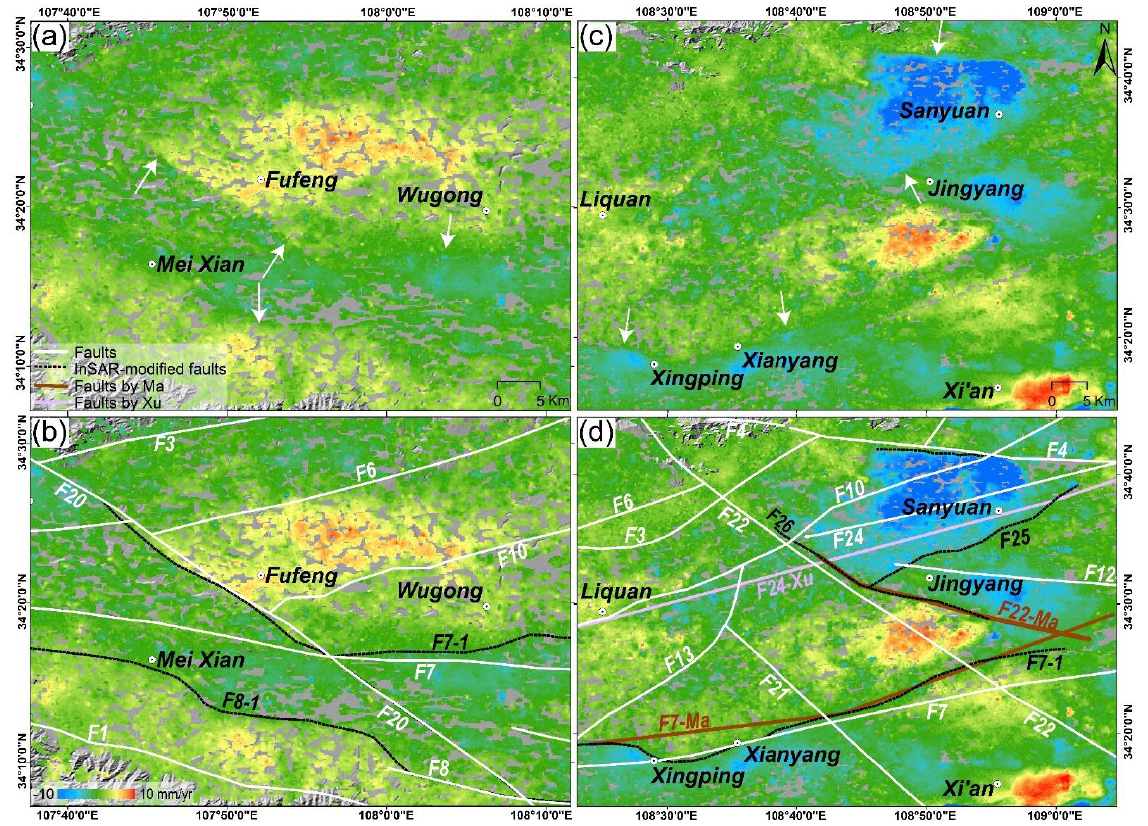
Figure 8. Enlarged vertical deformation maps over the Fufeng ( a , b ) and Sanyuan ( c , d ) regions, where the mapped faults (white lines) [18], InSAR-modified faults (black lines), and faults in Ma et al., 2018 (brown lines) [53] and Xu et al., 2017 (pink line) [54], and the main cities are superimposed. In addition to the modification of active fault positions in regard to [18], we also drew two new fault lines over the Jingyang area, i.e., F25 and F26, based upon our InSAR dis- continuities. The mapped F25 tends to trend parallel to F10, F24, and F24-Xu in an ENE direction, and bound the Sanyuan subsidence cone in the south [18,37]. It looks as if F25 is involved in a listric faulting system together with F24, and the existence of F24, F24-Xu, and F25 acts as a barrier against groundwater motion, disrupting the integrity of ground- water flows and limiting the lateral extent of the Sanyuan settlement pattern. According to a previous study, an active fault has been developing in the Weihe Basin, and a variety of listric faults occurred along existing fault positions because of the continuous extending of the continental crust related to the Ordos Block [8]. F26 is generally mapped along the Jinghe River, trending parallel to the F22 in the northern half-section. The InSAR-derived fault line is perfectly coincidental with that from [53]. 7. Conclusions Utilizing C-and L-band SAR images collected during the period of 2015 – 2019, we explored the spatial distribution of ground deformation and the geometric distributions, slip rates, and structures of active faulting in the Weihe Basin. Combining InSAR data with leveling measurements and deformation modeling, we draw the following conclu- sions: First, basin-wide average InSAR deformation maps during 2015 – 2019 were derived by Sentinel-1A/B and ALOS PALSAR2 ScanSAR scenes. The peak subsidence and uplift